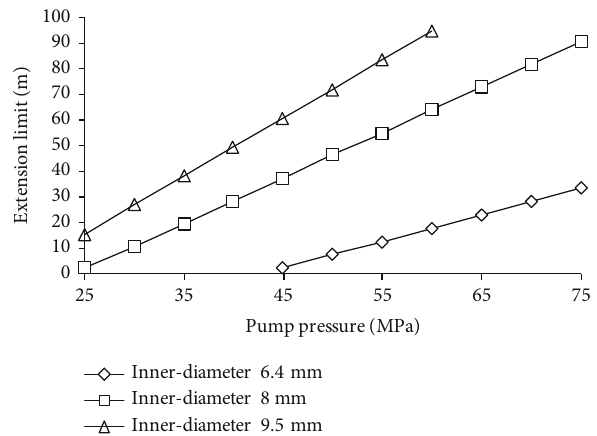
Figure 4: Force distribution of the RJD system.